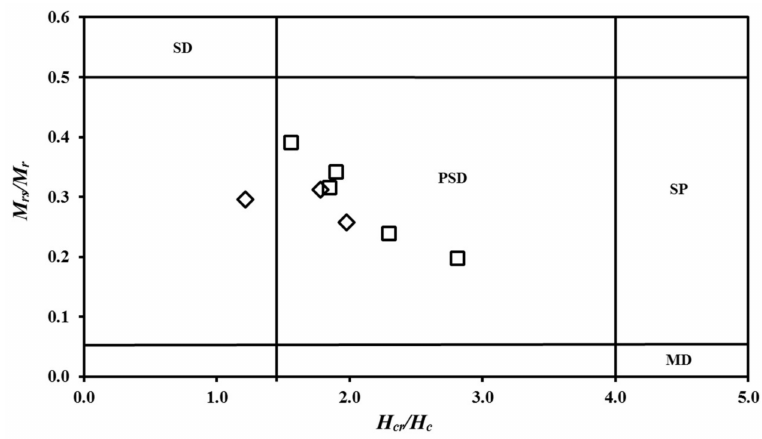
Figure 6. Hysteresis parameters on a Day’s Plot [45] for all samples. SD: Single Domain, PSD: Pseudo Single Domain, MD: Multi Domain, SP: Superparamagnetic. Symbols: hollow square—Ijen Crater, hollow diamond—Mount Anyar.